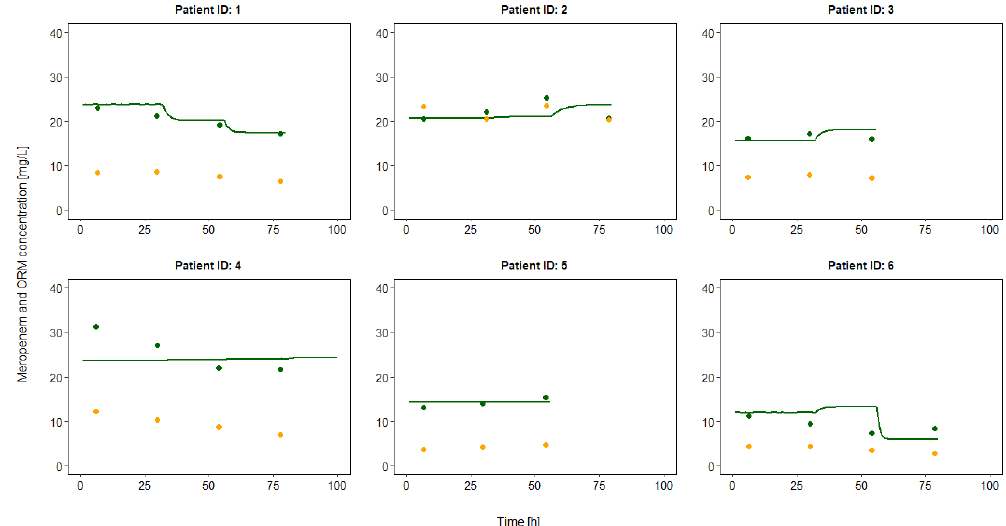
Figure 5. Observed meropenem and open-ring metabolite (ORM) concentrations and meropenem concentration–time profile predicted based on a one-compartment pharmacokinetic model. Green line: median predictions, green points: meropenem concentrations, orange points: ORM concentrations.